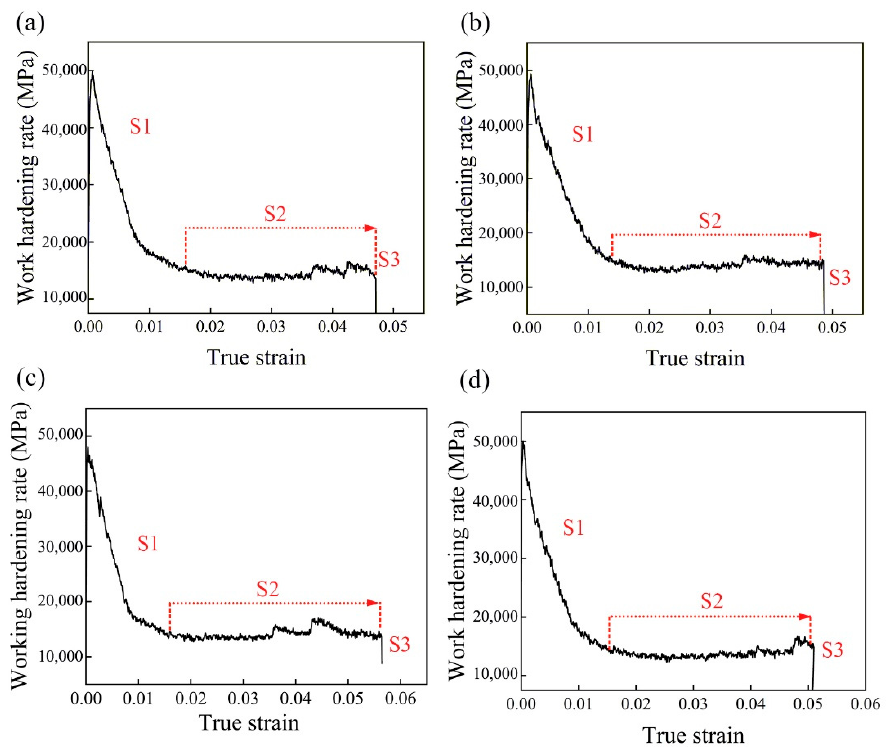
Figure 6. Work hardening curves after solution treatment at different temperatures: ( a ) 900 °C; ( b ) 1000 °C; ( c ) 1100 °C; ( d ) 1200 °C.